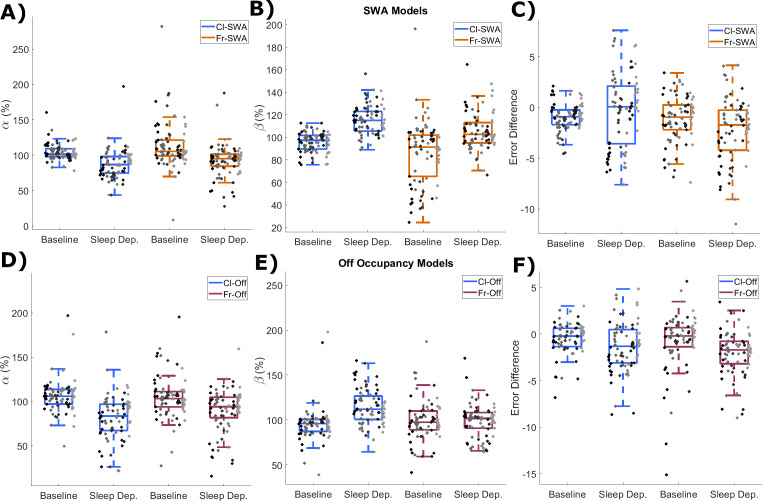
Cross-validation of parameter estimation.(A) The values of the rate parameters α, and (B) β, obtained by algorithmic optimisation fitting to data from only the baseline or sleep deprivation day. For normalisation, values are expressed as a percentage of the original value obtained using the semi-automated approach (see Materials and methods). (C) The difference in the median percent error (E*) obtained from Process S with rate parameters optimised on either the baseline or sleep deprivation day from that obtained using the original semi-automated selected parameters. Negative values reflect improved fits. All values are shown for both classic (blue) and firing-rate-based (orange) models applied to SWA-derived Process S. (D–F) The same variables are shown for the models based on off occupancy using both classic (blue) and firing-rate-based (purple) models. Statistical analysis was performed for each variable by a three-factor ANOVA. (A) Day: F(1, 293)=56.1, p=8.1×10−13; Model: F(1, 293)=6.8, p=9.7×10−3; Animal: F(5, 293)=1.4, p=0.23; Day x Model: F(5, 293)=0.6, p=0.43; Day x Animal: F(5, 293)=4.8, p=3.5×10−4; Model x Animal: F(1, 293)=2.5, p=0.033; three-way ANOVA). (B) Day: F(1, 293)=110.9, p=3.3×10−22; Model: F(1, 293)=28.9, p=1.6×10−7; Animal: F(5, 293)=0.7, p=0.60; Day x Model: F(5, 293)=0.1, p=0.98; Day x Animal: F(5, 293)=11.1, p=8.3×10−10; Model x Animal: F(5, 293)=11.6, p=7.4×10−4; three-way ANOVA). (C) Day: F(1, 293)=4.37, p=0.038; Model: F(1, 293)=16.3, p=7.1×10−5; Animal: F(5, 293)=17.3, p=5.3×10−15; Day x Model: F(1, 293)=2.1, p=0.064; Day x Animal: F(5, 293)=24.5, p=1.4×10−20; Model x Animal: F(1, 293)=3.6, p=3.9×10−3; three-way ANOVA). (D) Day: F(1, 281)=48.2, p=2.6×10−11; Model: F(1, 281)=2.6, p=0.11; Animal: F(5, 281)=2.6, p=0.027; Day x Model: F(5, 281)=3.2, p=0.077; Day x Animal: F(5, 281)=2.9, p=0.014; Model x Animal: F(1, 281)=0.8, p=0.54; three-way ANOVA). (E) Day: F(1, 281)=16.8, p=5.4×10−5; Model: F(1, 281)=4.6, p=0.033; Animal: F(5, 281)=0.8, p=0.50; Day x Model: F(5, 281)=13.0, p=3.7×10−4; Day x Animal: F(5, 281)=6.0, p=2.7×10−5; Model x Animal: F(1, 281)=1.2, p=0.31; three-way ANOVA). (F) Day: F(1, 281)=15.9, p=8.4×10−5; Model: F(1, 281)=1.4, p=0.25; Animal: F(5, 281)=7.5, p=1.2×10−6; Day x Model: F(5, 281)=0.3, p=0.56; Day x Animal: F(5, 281)=2.6, p=0.028; Model x Animal: F(1, 281)=0.8, p=0.58; three-way ANOVA).